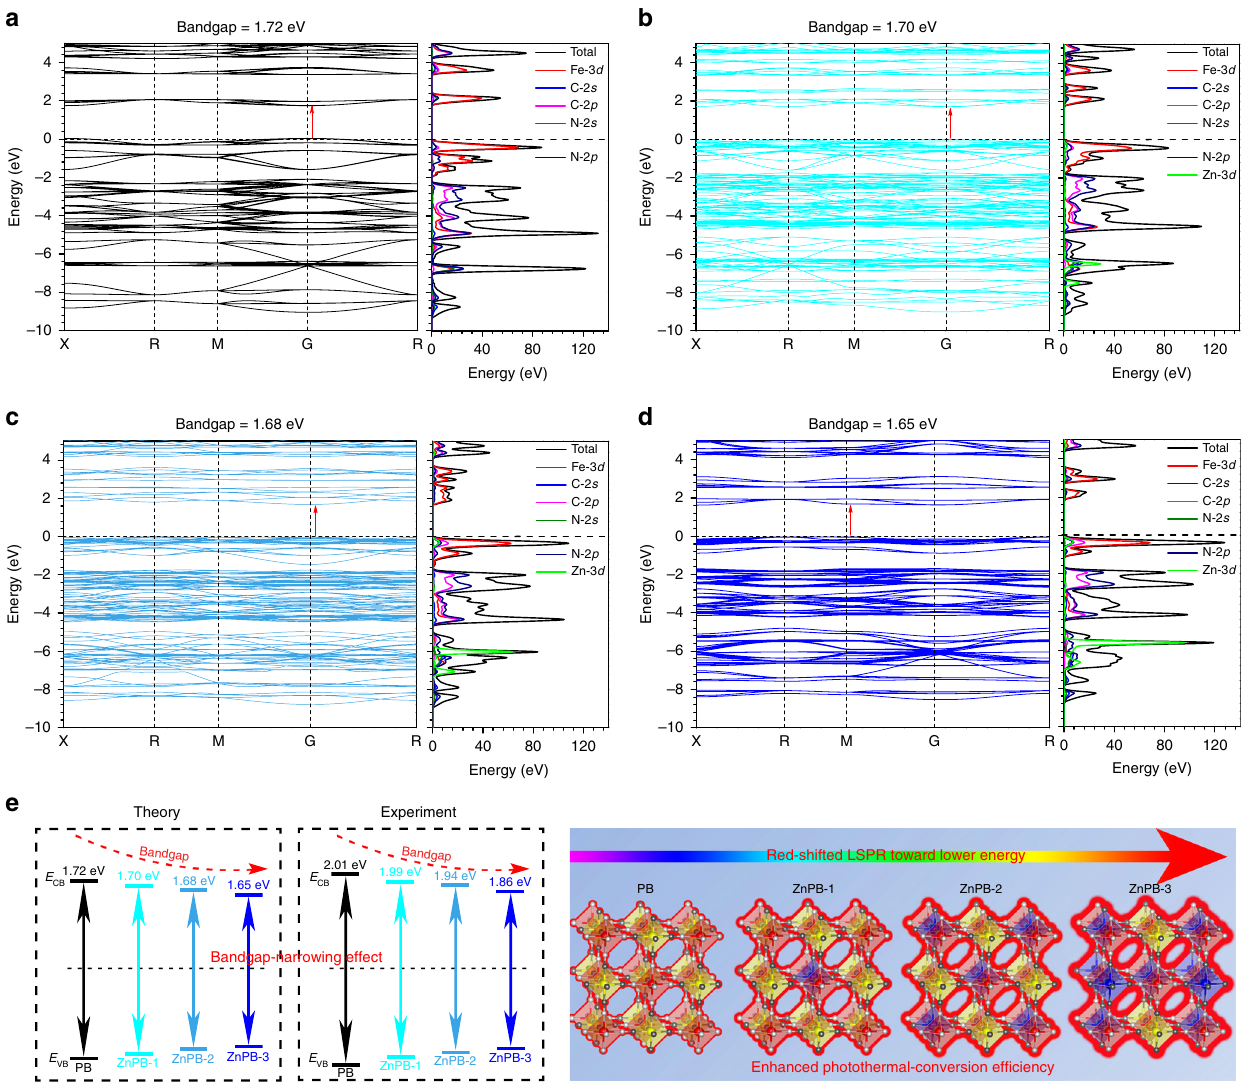
Fig. 3 Mechanism of enhanced photothermal conversion ef fi ciency. Theoretical calculations of band structure and density of states (DOS) of a PB, b ZnPB- 1, c ZnPB-2 and d ZnPB-3. e Scheme of bandgap-narrowing effect with the increase of Zn-doped density by theory and experiment, and mechanism of enhanced photothermal conversion ef fi ciency with the increase of Zn-doped density. Source data are provided as a Source Data fi different periods (0, 1 and 7 days), as shown in Supplementary